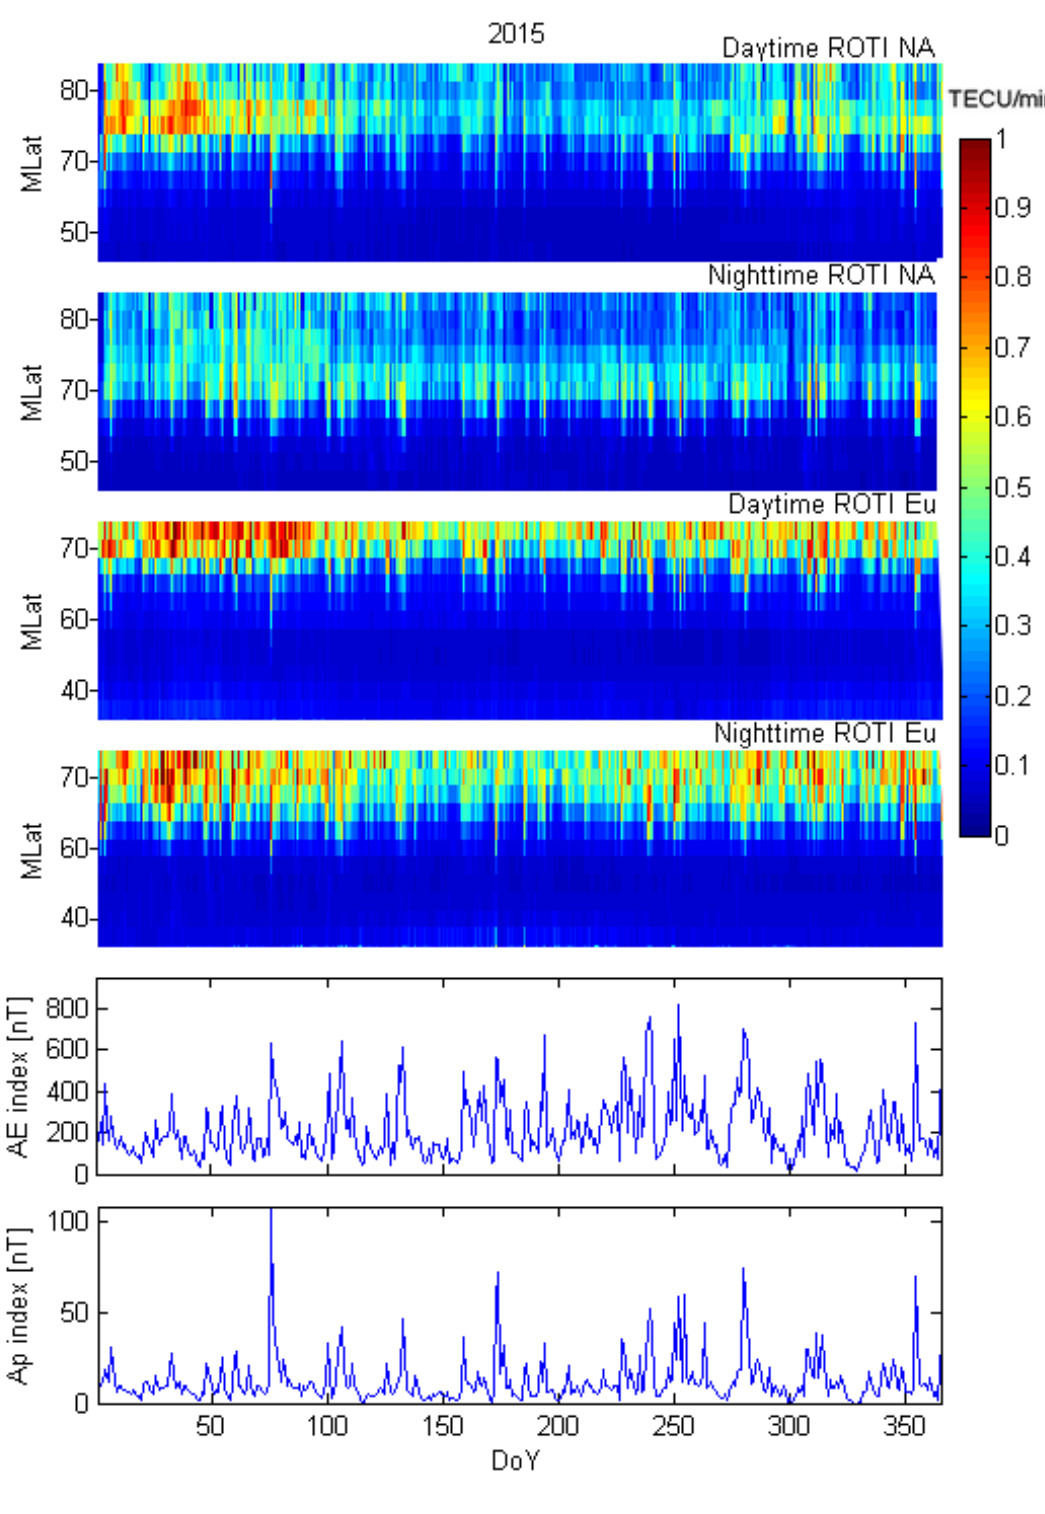
Figure 6. The same as Figure 5 but for the year